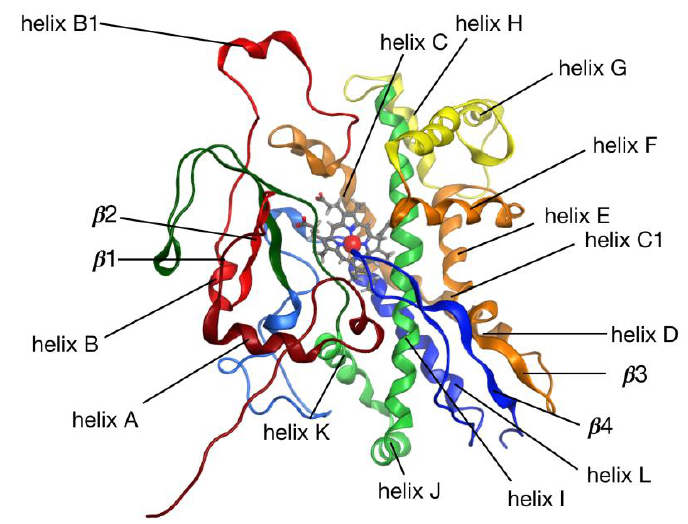
Figure 5. A 3D model of CYP128A1 with structured regions labeled. Heme and the iron atom are shown in grey and red, respectively.